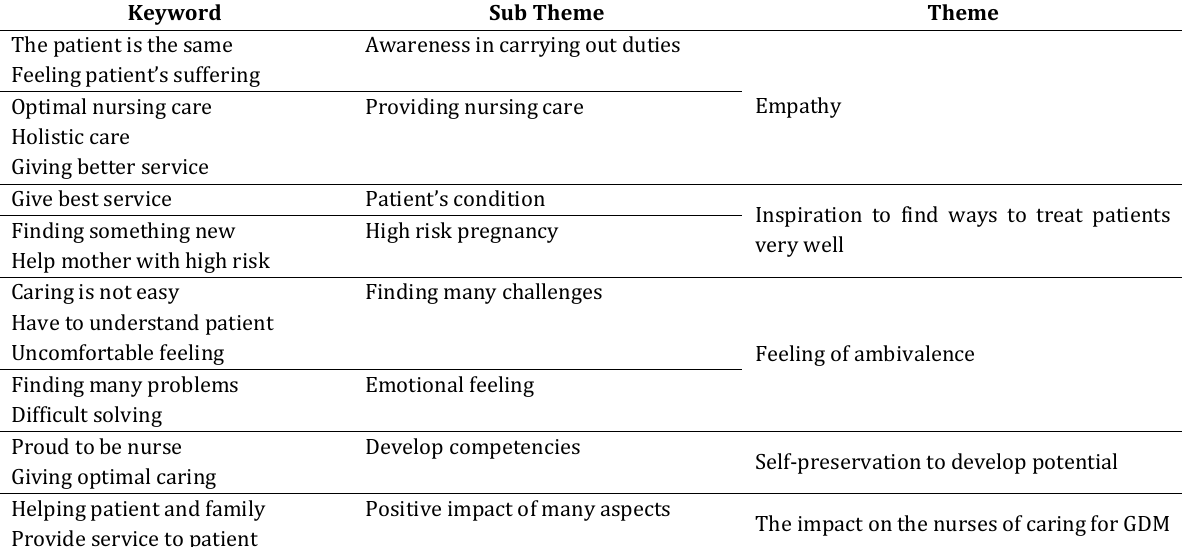
Table 3. Thematic Analysis of the